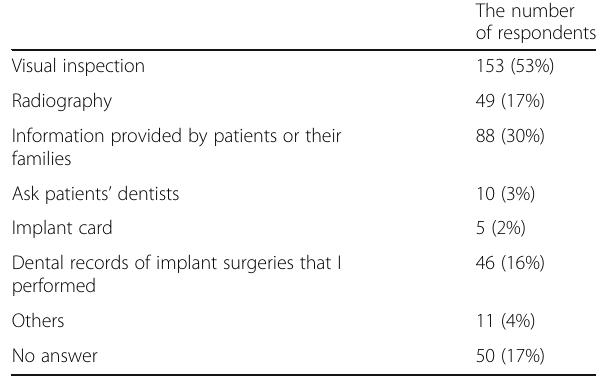
Table 6 Methods to identify the presence of implants